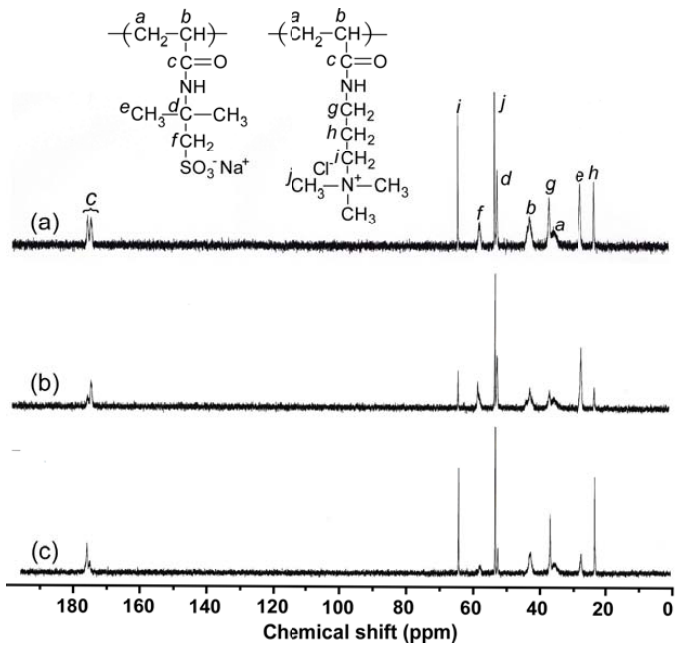
Figure 2. Inverse gated decoupling 13 C NMR spectra of ( a ) P(SA) 91 , ( b ) P(SA) 91 S 67 , and ( c ) P(SA) 91 A 88 in D 2 O.